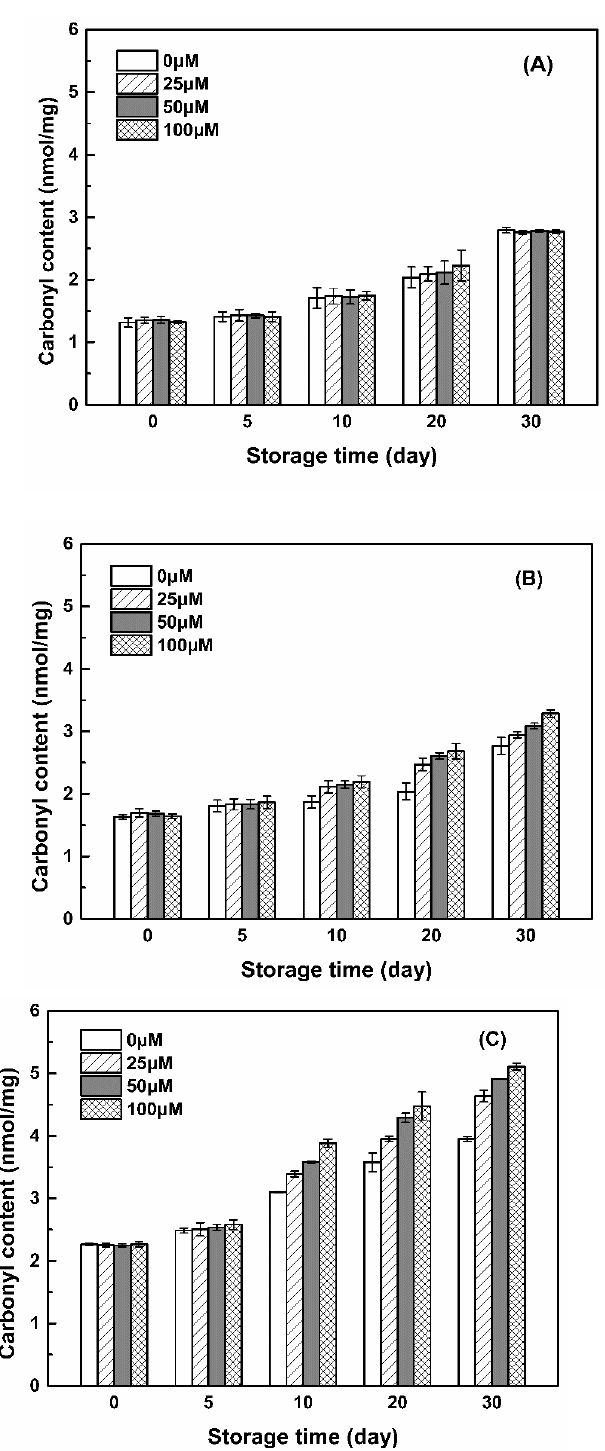
Figure 8. Carbonyl content of proteins in WPI-resveratrol ( A ), SC-resveratrol ( B ) and SPI-resveratrol ( C ) complex nanoparticles with various resveratrol concentrations during storage at 45 °C for 30 days. The concentration of proteins was 1%.